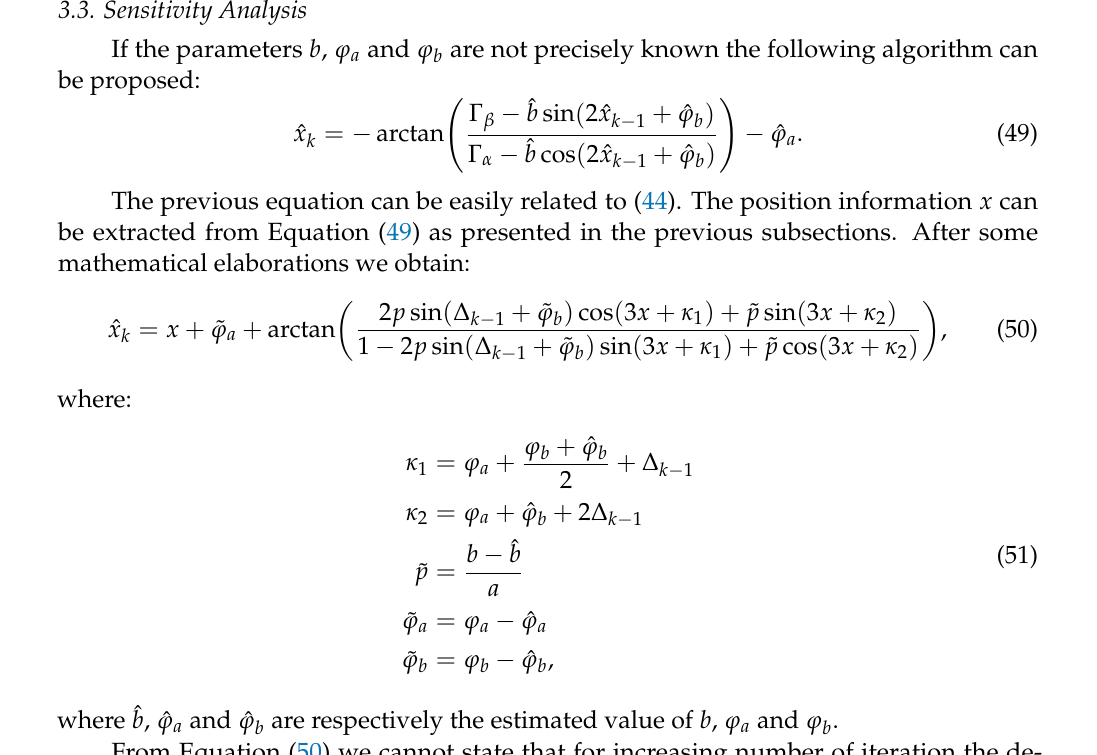
Figure 9. Flowchart of the IVD-DFC algorithm. The highlighted part in blue is the iterative part. It is assumed that the vector Γ ss is a zero vector for k = α , β